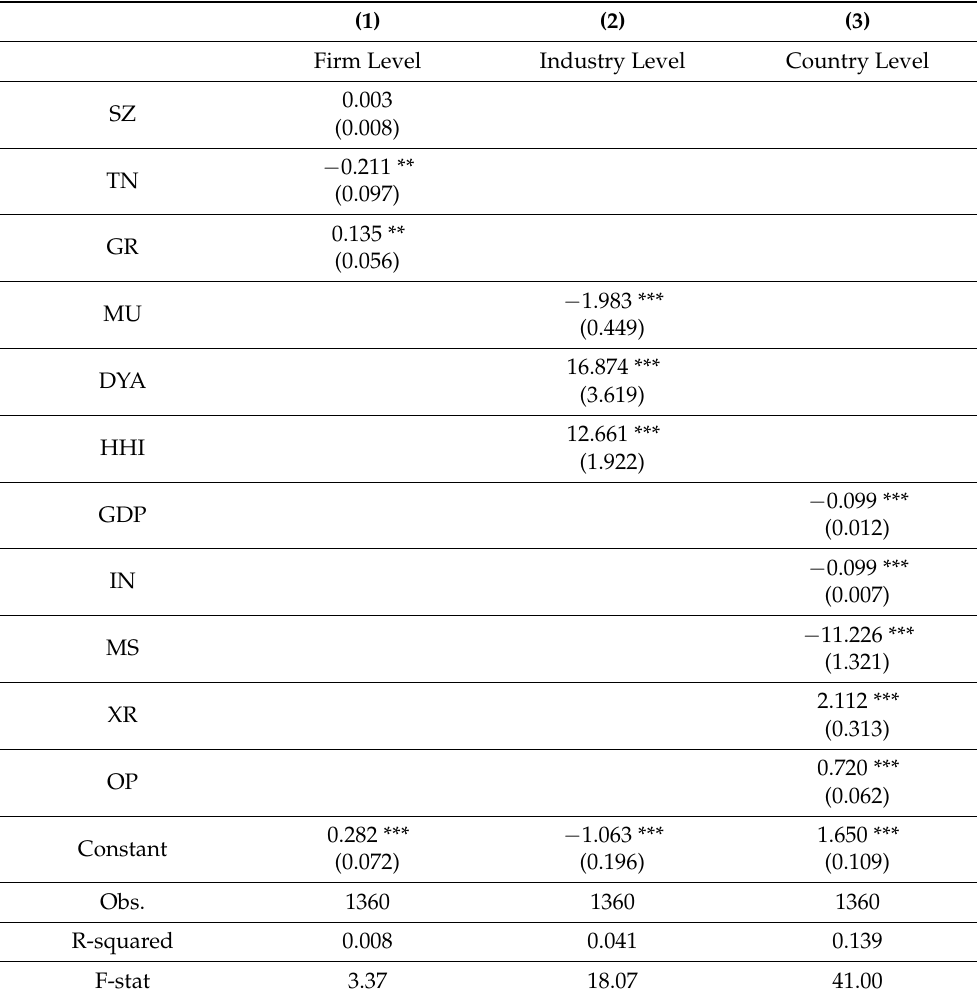
Table 2. Fixed effect regression